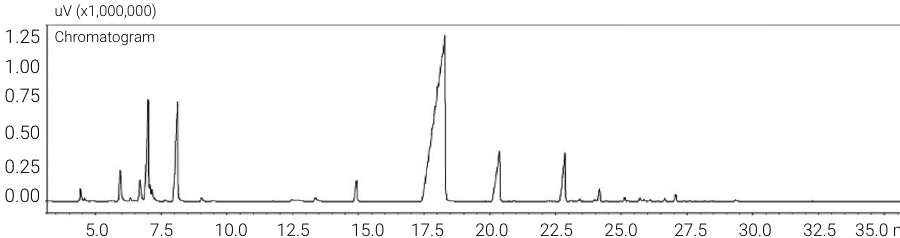
Figure 2. L. thymoides chromatographic